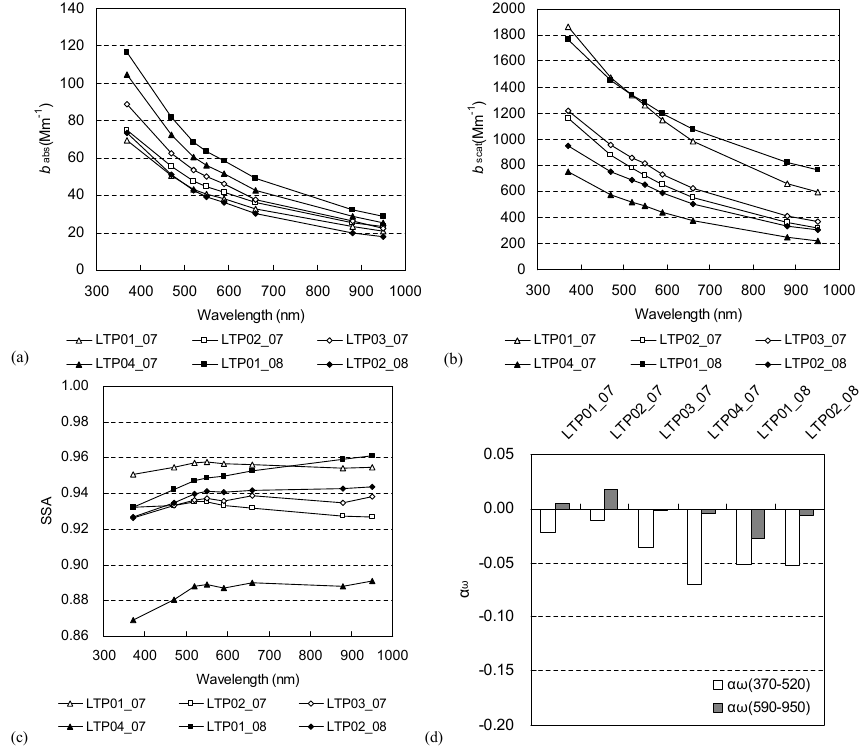
Figure 17. Fig. 16. (a) b abs , (b) b scat , and (c) SSA as a function of wavelength as well as (d) α ω during the LTP periods.